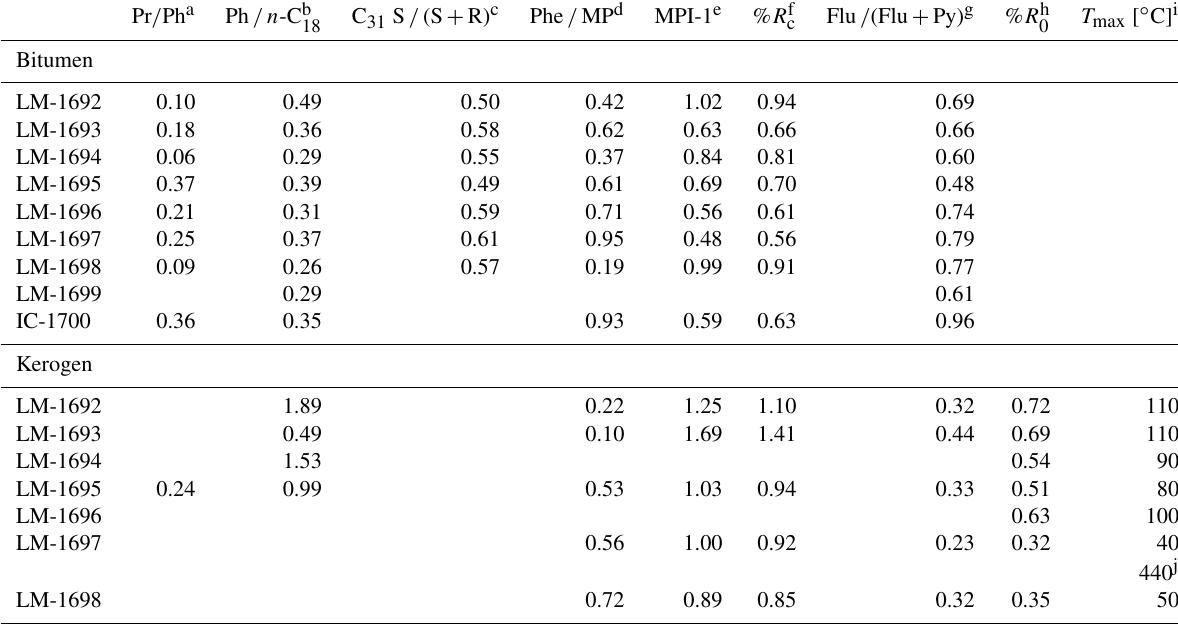
0.001 Table 2. Environmental and maturity parameters from biomarker analysis (GC-MS) and Raman spectroscopy. The C 31 hopane S / (S + R) ratios (third column) are all in the range of 0.5 to 0.6 and therefore near saturation, implying that most organic compounds may have reached the early oil window (vitrinite reflectance ≥ 0 . 6; Killops and Killops, 2005). These results are fully consistent with reflectances inferred from MPI-1 (fifth and sixth column). Raman data (rightmost two columns) have been acquired on few specific sample points and therefore reflect the heterogeneity of the sample rather than its bulk